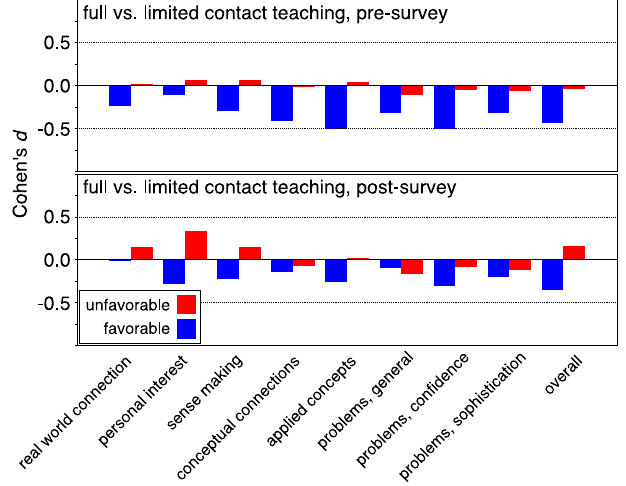
FIG. 4. Comparison of survey results for classes with full and limited contact teaching. Differences are calculated in such a way that a positive value means the class with limited contact teaching scored